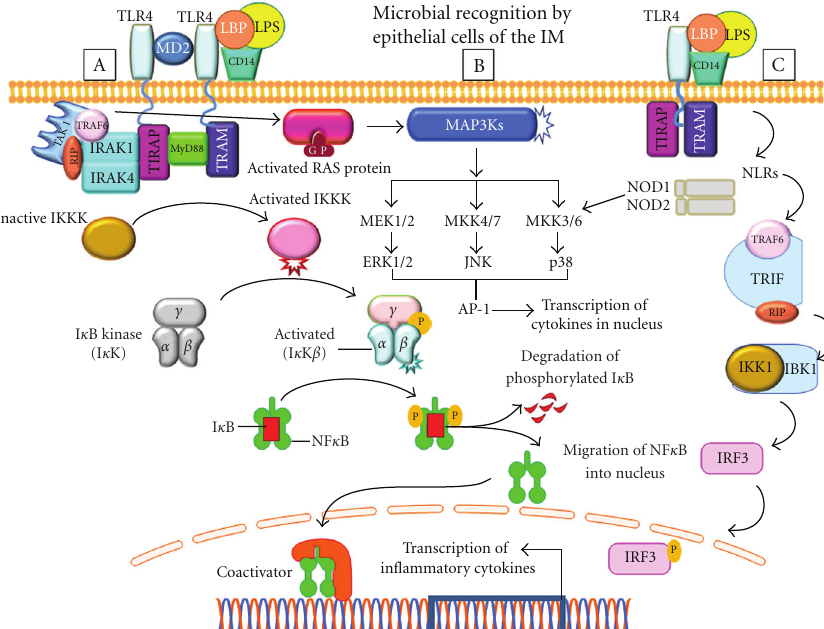
Figure 2: A schematic illustration of the recognition of microbial associated molecular patterns (MAMPs), such as LPS (lipopolysaccharide), by pattern recognition receptors (PRRs) on epithelial cells and activation of three (A, B, and C) pathways that induce production of pro- inflammatory cytokines or chemokines. A. Expressed on the cell membrane of most intestinal epithelial cells (IECs), toll-like receptors (TLRs) are triggered by LPS. Four toll-like interleukin receptor (TIR) adaptors become involved in propagating TLR signaling, including Myd 88 (myeloid di ff erentiation primary-response gene 88), TIRAP (toll-interleukin-1 receptor domain containing adapter protein), TRAM (translocating chain-associated membrane protein), and the TRAF (TNF receptor associated factor) protein family. This interaction induces phosphorylation and activation of TAK1, leading to activation of IKKs. Inactive IKK sequesters NF κ B in the cytoplasm and leads to degradation of I κ B, with subsequent release of NF κ B that induces transcription of pro-inflammatory cytokines and chemokines. B. In various cells, Myd 88-dependent signaling is associated with activations of TAK1, also known as MAP kinases. Extracellular signal-regulated kinase (MEK) is an intermediary of the MAPK pathway. Activated MEK subsequently phosphorylates ERK which translocates to the nucleus where it activates multiple transcription factors. Cytoplasmic nucleotide-binding oligomerization domain-like (NOD) receptors also recognize MAMP. The ligand NOD1 recognizes a peptidoglycan, a constituent only of gram-negative bacteria. NOD2 recognizes constituents of both gram-positive and gram-negative bacteria. NODs transduce signals in the pathway of NF κ B and MAP